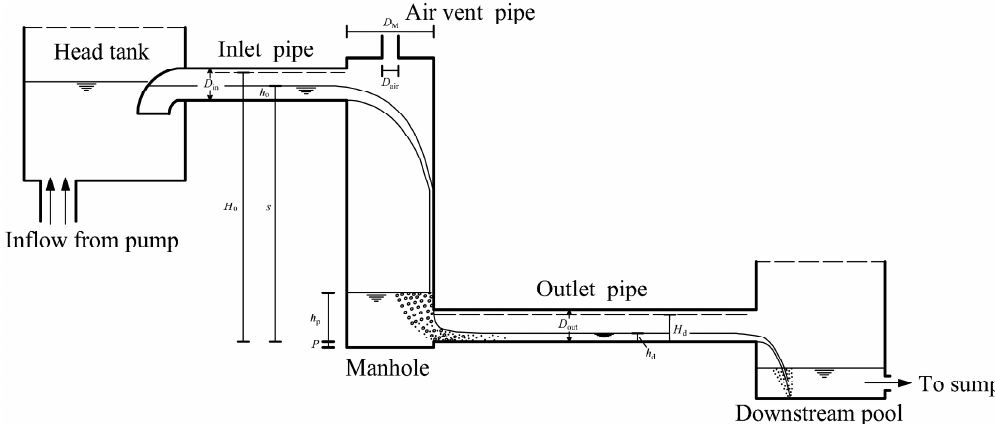
Figure 1. Sketch of experimental setup.